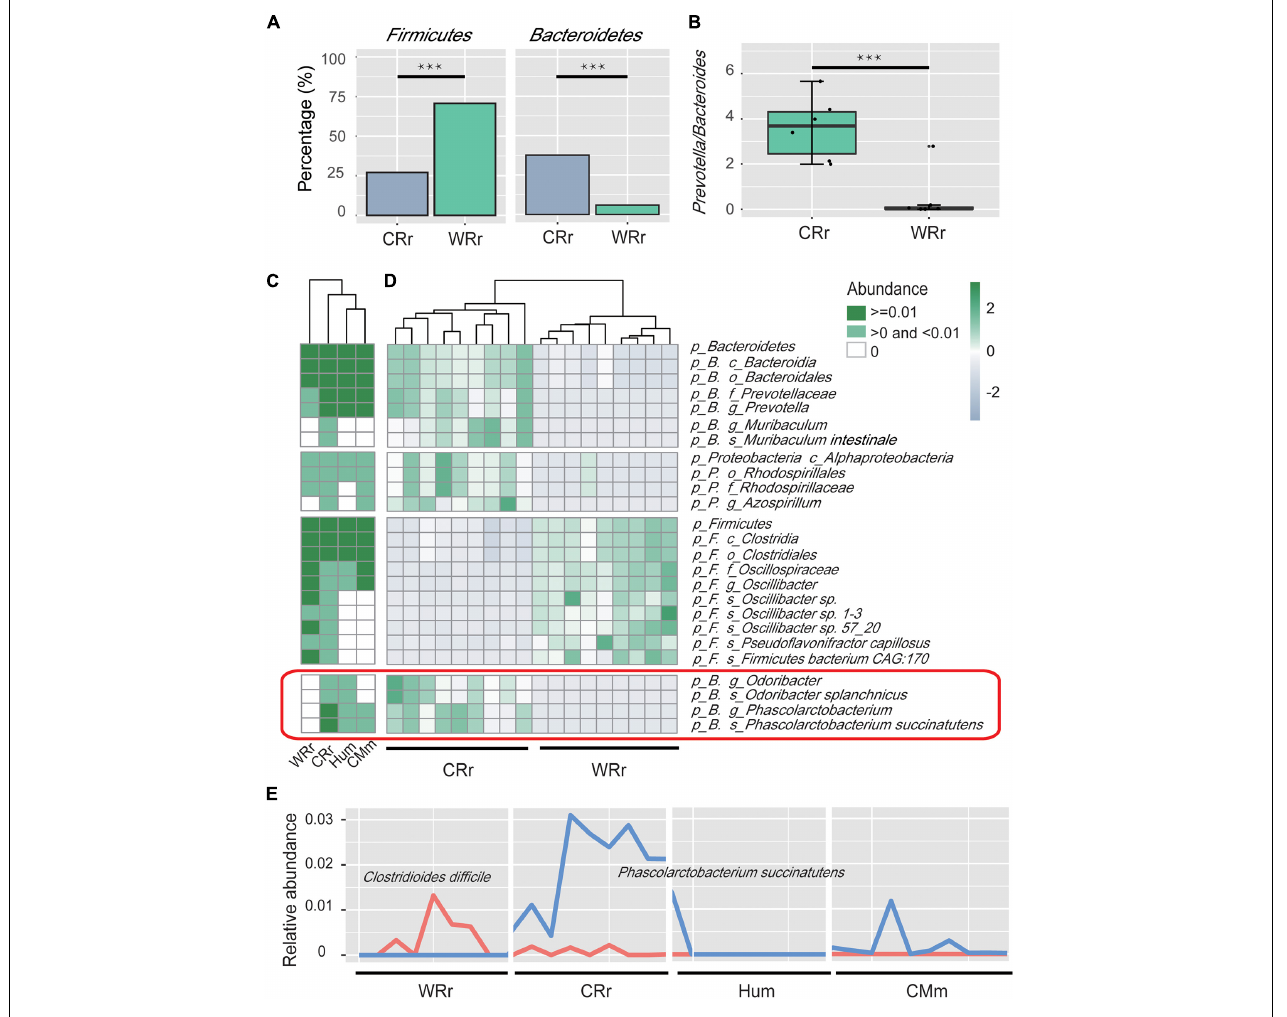
FIGURE 2 | Microbial community profiles of captive and wild R. roxellana microbiome. (A) Bar plots showing the relative abundance of Firmicutes and Bacteroidetes between WRr and CRr samples. Three asterisk indicates significant differences ( p (FDR)-value < 0.001). (B) Box plots showing the Prevotella / Bacteroides (P/B) ratio of WRr and CRr samples. (C) The average relative abundance of taxa in the four cohorts (white = average relative abundance = 0; light green = average relative abundance < 0.01; dark green = average relative abundance > 0.01). (D) A heatmap showing the taxonomic terms that were significantly different [ p(FDR) < 0.005] between wild and captive R. roxellana . Bacteria in the red box were shared by CRr, Hum, and CMm samples but not WRr samples. (E) The distribution of the relative abundances of C. difficile and P. succinatutens among the four cohorts. Panel (A–E) indicate the significant differences in bacterial communities between CRr and WRr samples, and the captive populations share some fecal microbes with